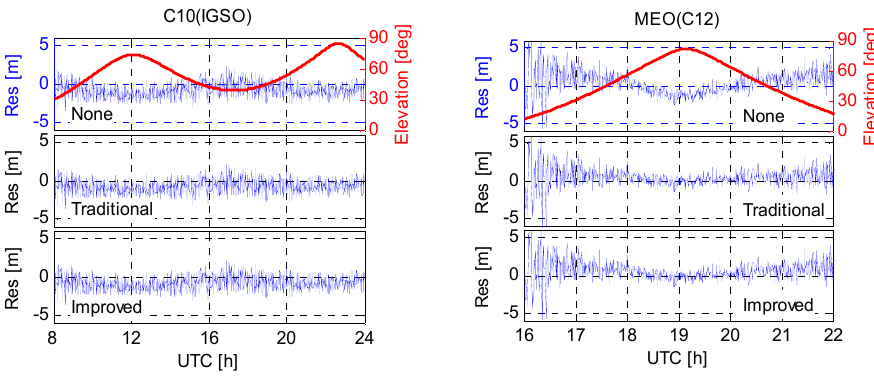
Figure 15. Time series of representative code residuals on XMIS (DoY 130/2015).